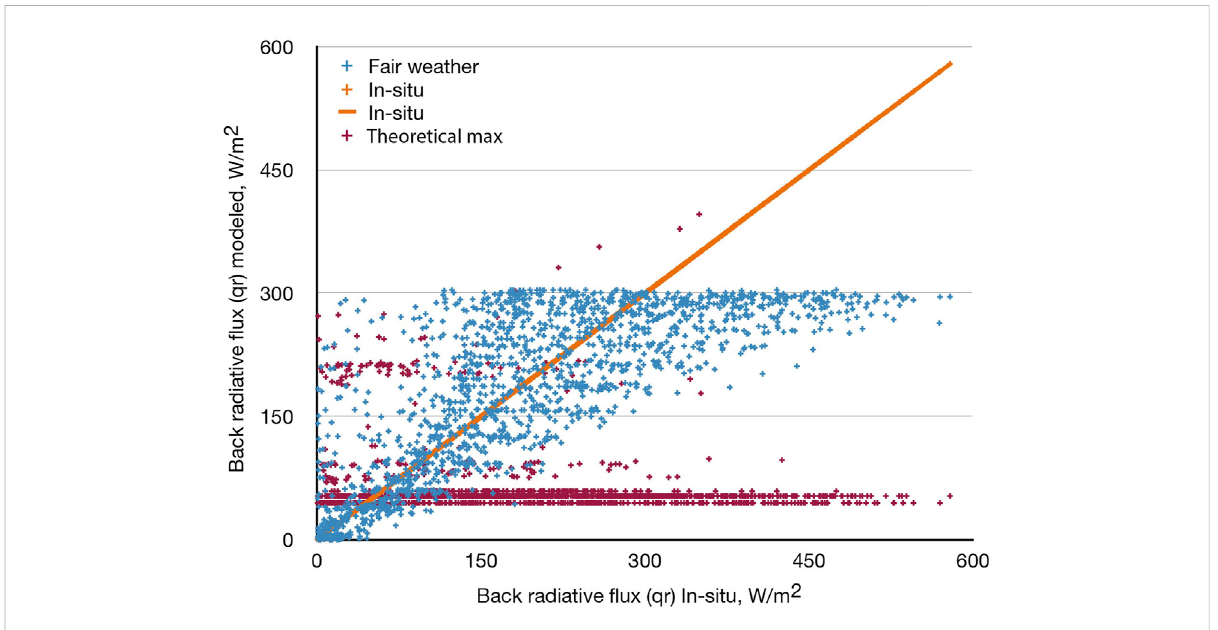
FIGURE 10 Back side radiative transfer